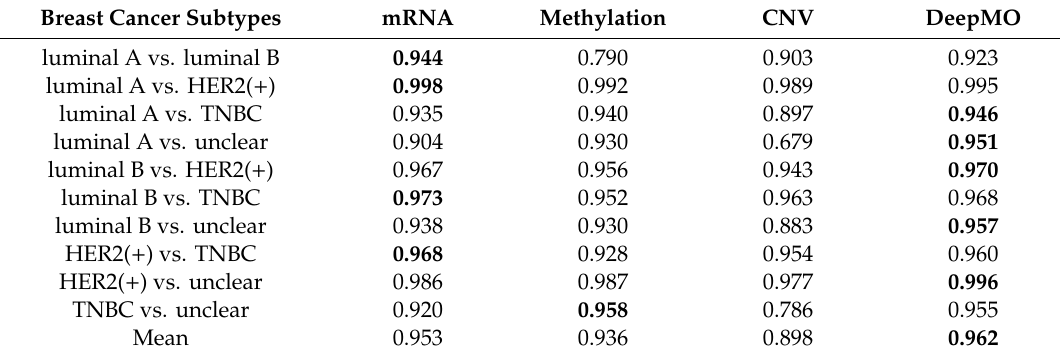
Table 5. The area under the curve (AUC) values of any two breast cancer subtypes with di ff erent types of omics data and multi-omics data by DeepMO. Bold numbers are the best performance of binary